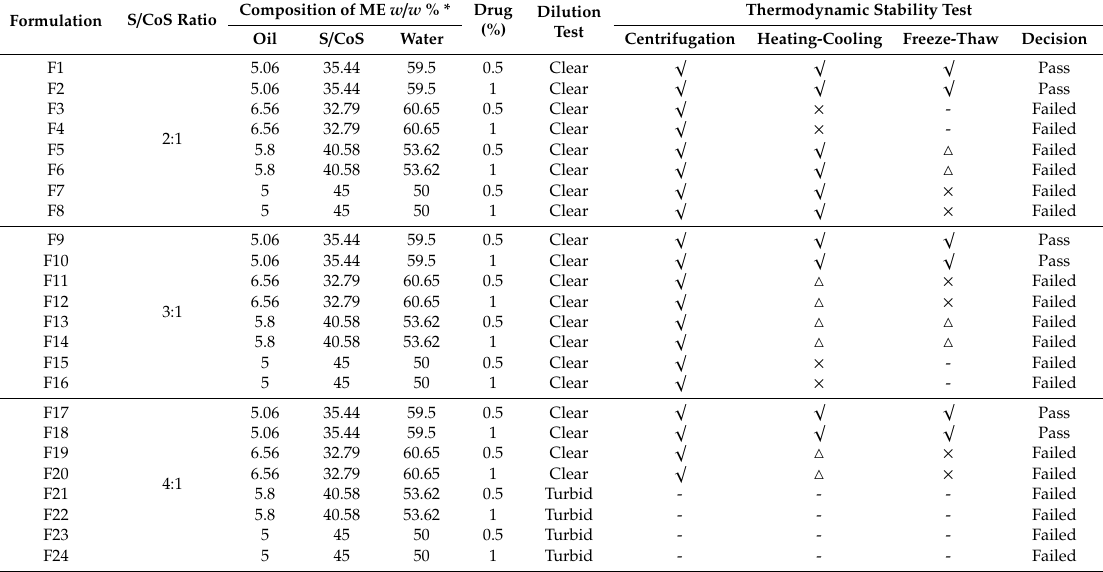
Table 2. Compositions, drug loading, and thermodynamic stability test of formulations 1 to 24 o / w microemulsions.